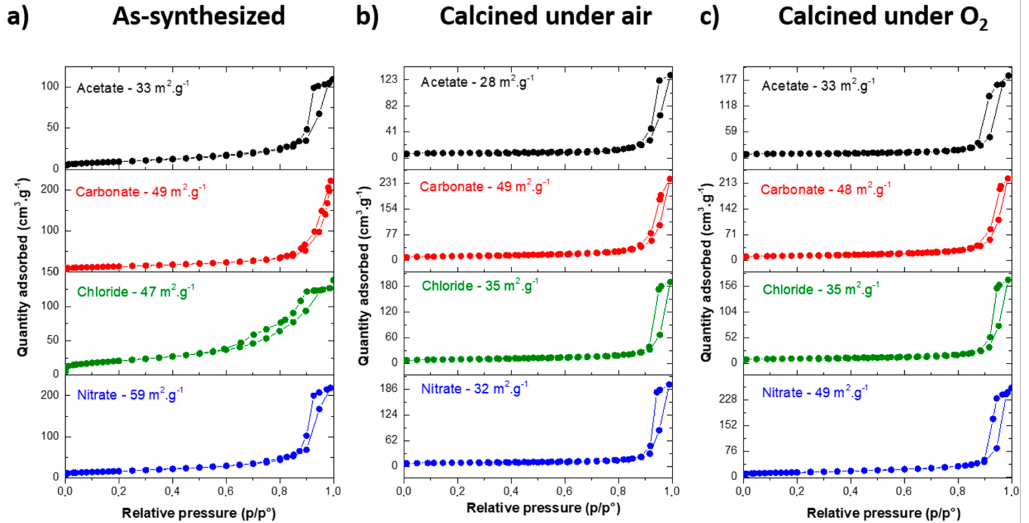
Figure 5. N 2 adsorption and desorption isotherms of ( a ) as-synthesized; ( b ) calcined in air and ( c ) calcined in O 2 MgF 2 prepared from acetate, carbonate, chloride and nitrate magnesium precursors, after HF